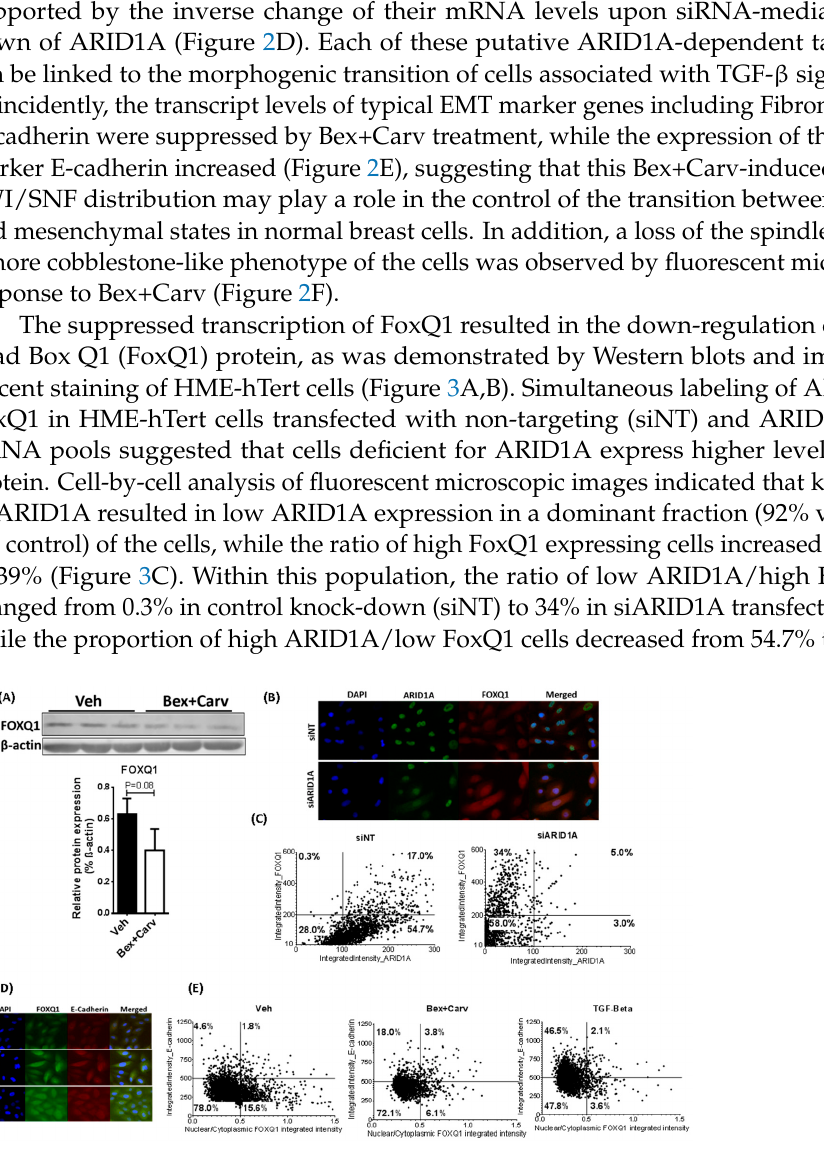
Figure 3. ARID1A-dependent regulation of FoxQ1 and E-cadherin by Bex+Carv and TGF- β in HME- hTert cells. ( A ) (Top) Western blot analysis of FoxQ1 protein levels in HME-hTert cell extracts upon Vehicle vs 100 nmole/L Bex + 1000 nmole/L Carv treatment for 48 h. (Bottom) quantification of FoxQ1 protein expression levels upon the combination treatment. β -actin was used as a housekeep- ing gene for normalization. N = 3 representing 3 biological replicates. ( B ) Representative images of HME-hTert cells transfected with siRNA against luciferase as a non-targeting control (siNT) or ARID1A (siARID1A) for 72 h and immunostained against ARID1A (green) and FoxQ1 (red), images were taken at 20× magnification. ( C ) Scatter plots categorizing cells based on their ARID1A and FoxQ1 protein levels upon transfection with siRNA against Luciferase (siNT, left) or against ARID1A (siARID1A, right). A minimum of 1000 cells were individually analyzed using CellProfiler software based on the integrated intensity of ARID1A and FoxQ1 staining in the nucleus or whole cell, respectively. ( D ) Representative images of cells treated with Veh, 100 nmole/L Bex+ 1000 nmole/L Carv for 3 days, or 5 ng/mL TGF- β for 1 day and immunostained with for FoxQ1 and E- cadherin (20 x magnification). ( E ) Correlation between FoxQ1 nuclear translocation and E-cadherin levels based on nuclear/cytoplasmic ratio of FoxQ1 and cellular E-cadherin staining in cells treated with Veh (Left), 100 nmole/L Bex+ 1000 nmole/L Carv for 3 days (Middle) or 5 ng/mL TGF- β for 1 day (Right).